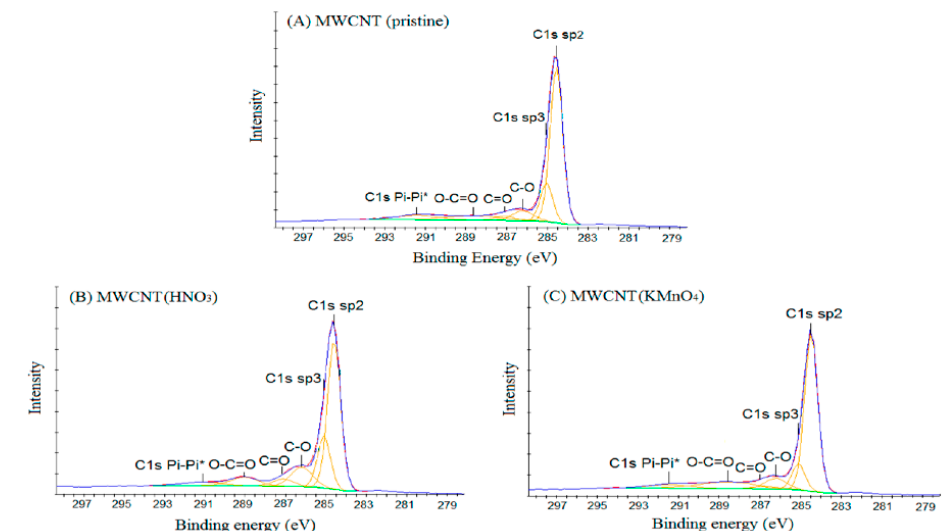
Figure 5. XPS C1s spectra for MWCNT(pristine) ( A ), MWCNT(HNO 3 ) ( B ) and MWCNT (KMnO 4 ) ( C ) samples.